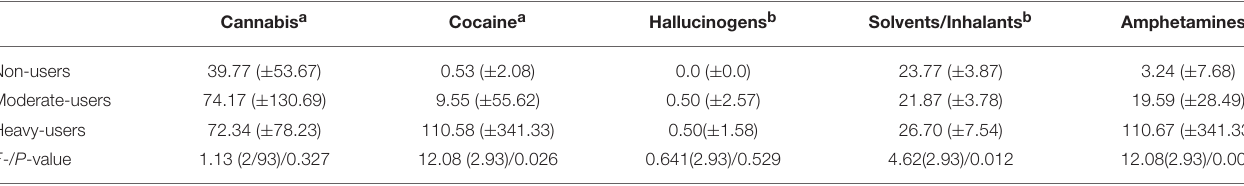
TABLE 2 | Concomitant illicit substances use.